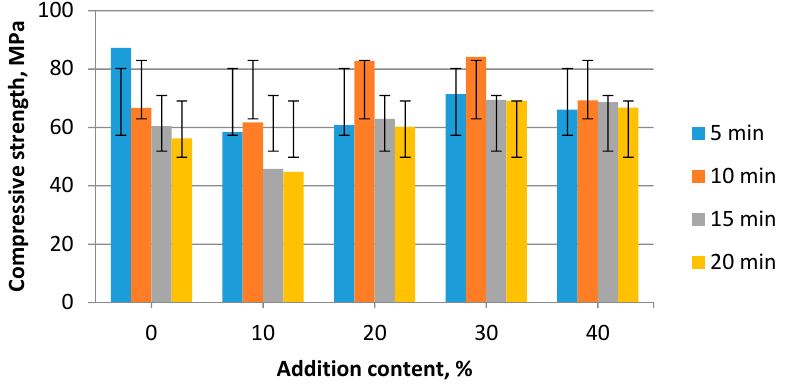
Figure 3. Dependence of the strength of composite binders on the time of grinding of the raw mixture and the amount of additives of substandard nephrite.